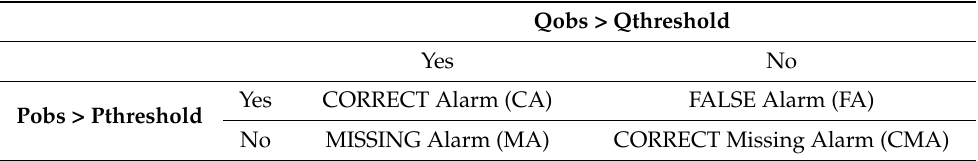
Table 2. Two-by-two contingency